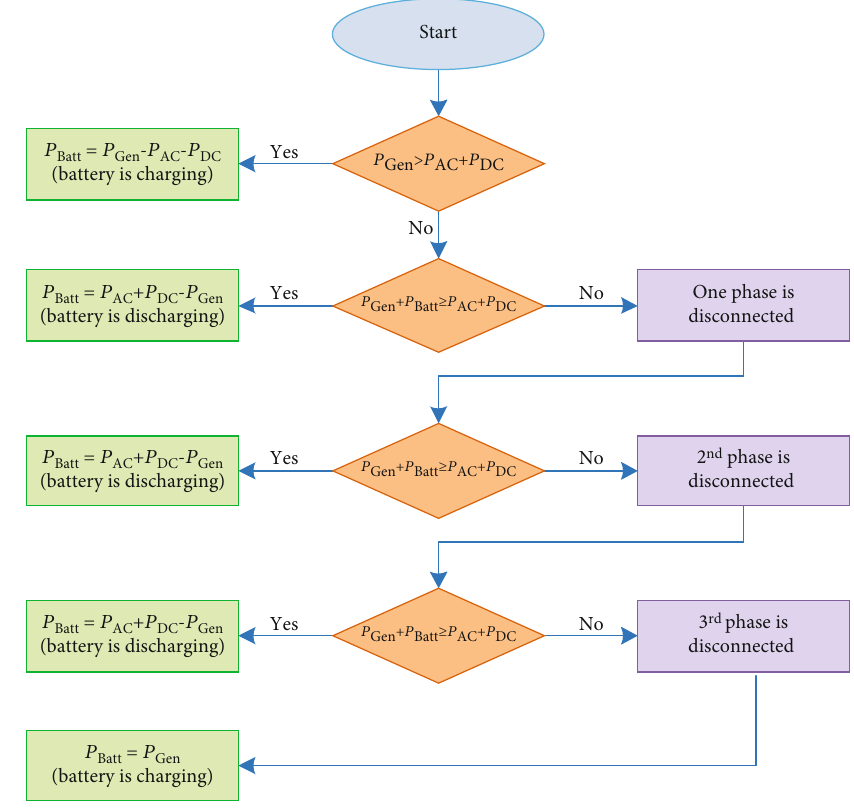
Figure 10: The block diagram of the power management system